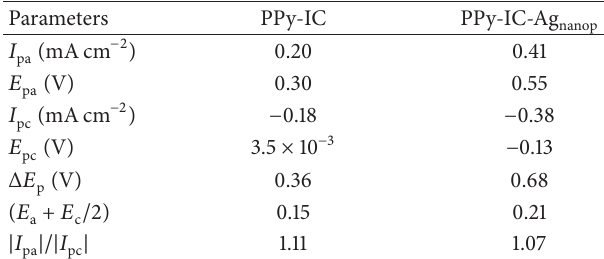
Table 1: Electrochemical parameters obtained from voltammo- grams of PPy-IC and PPy-IC-Ag nanop (Figure